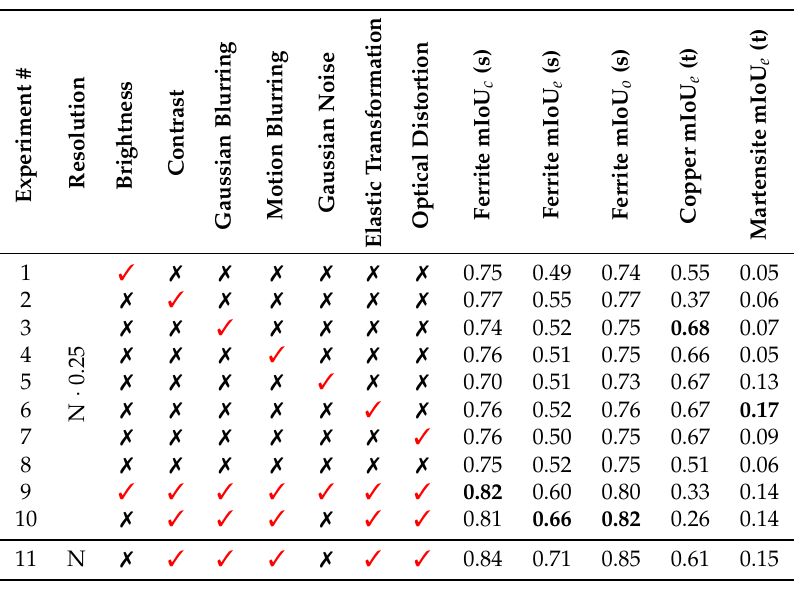
Table 3. Results of augmentation pipeline optimization. Note that even in experiment #8, non-mutual augmentations between this table and Table 2 are applied. (s) and (t) denotes source and target domains,